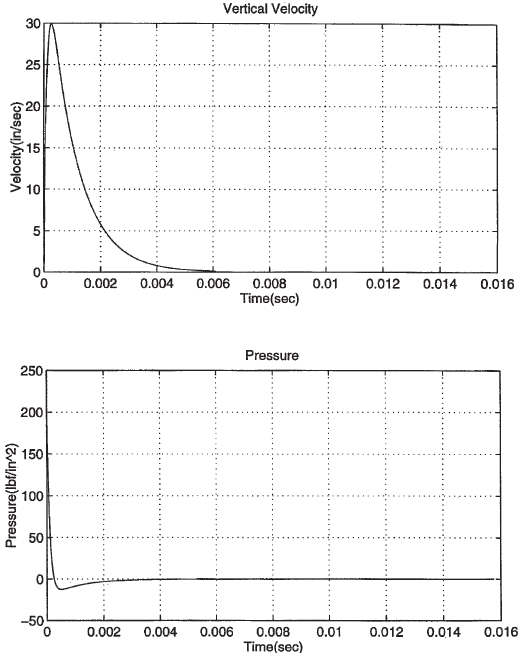
Fig. 4. Bleich–Sandler plate velocity and pressure (CFA